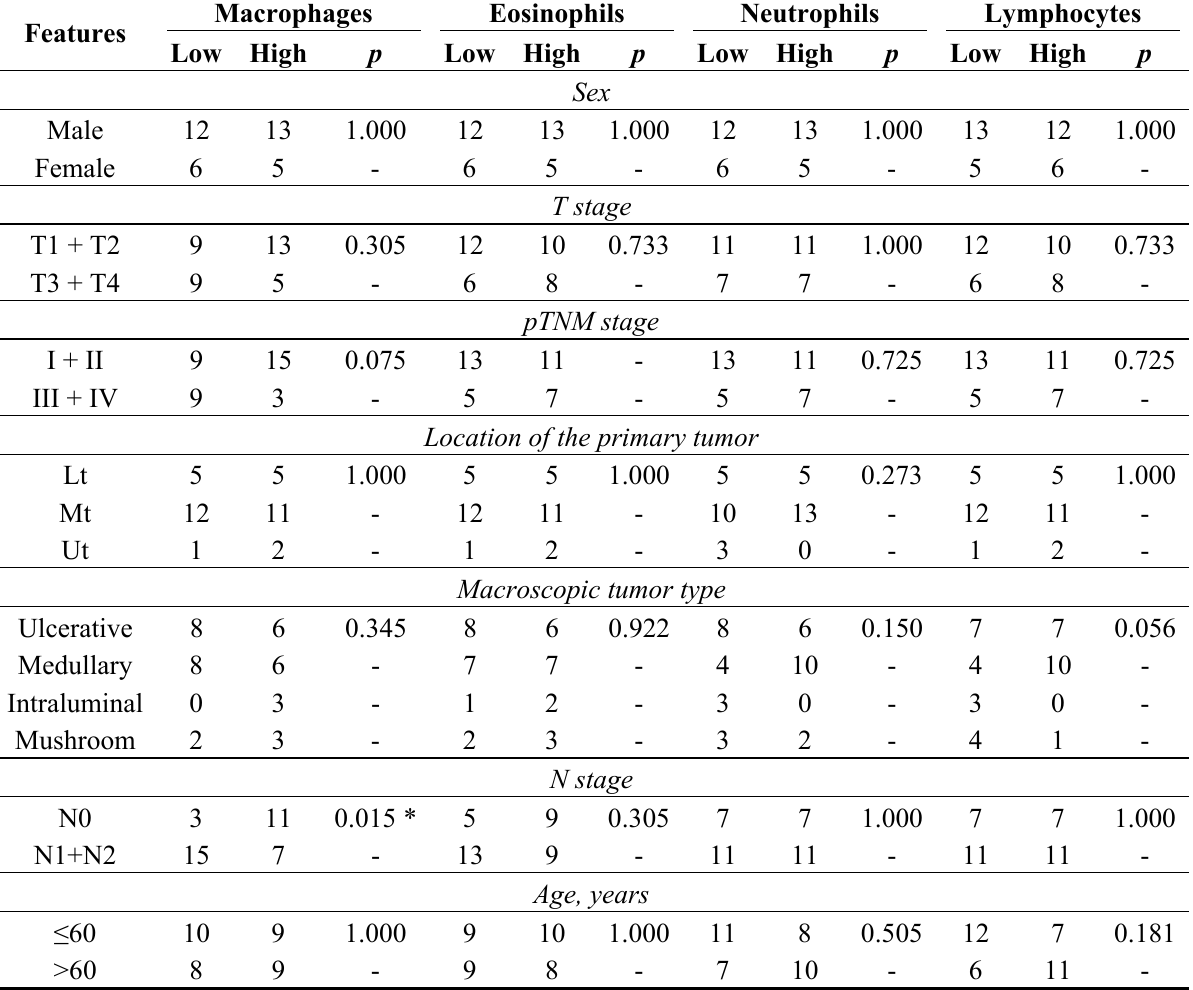
Table 2. Correlation of inflammatory-cell infiltration with clinicopathologic features of the 36 SmCEC